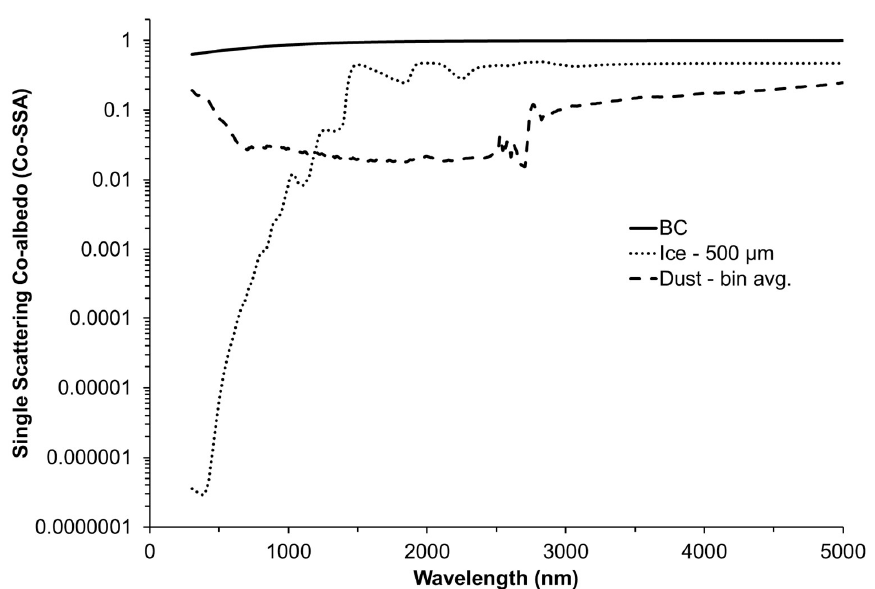
Figure 2. Single-scattering co-albedo (co-SSA = 1 − SSA) spectrum highlights the large discrepancy in the near-UV, visible, and near-IR wavelength regions (up to five to seven orders of magnitude) between the co-SSA of impurities, such as black carbon (BC) and mineral dust, compared to that of ice grains with a radius of 500 µm as used within the SNICAR model. Optical properties of BC were calculated using Mie theory with a number-mean diameter of 100 nm and a geometric standard deviation of 1.5. The co-SSA for dust has been averaged across all four size distributions available in SNICAR.